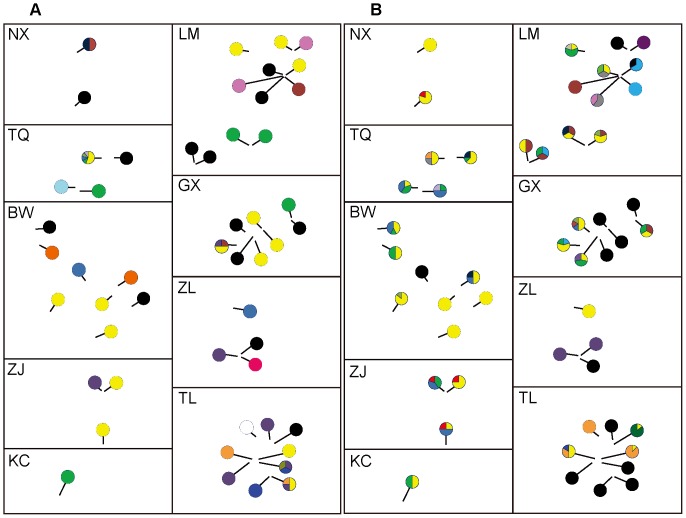
Distributions pattern of mtDNA ND2 gene haplotypes within localities.(A): males, (B): females. Haplotypes are labeled by colours in pie charts. Black circles represent no individual (male or female) within internodes.